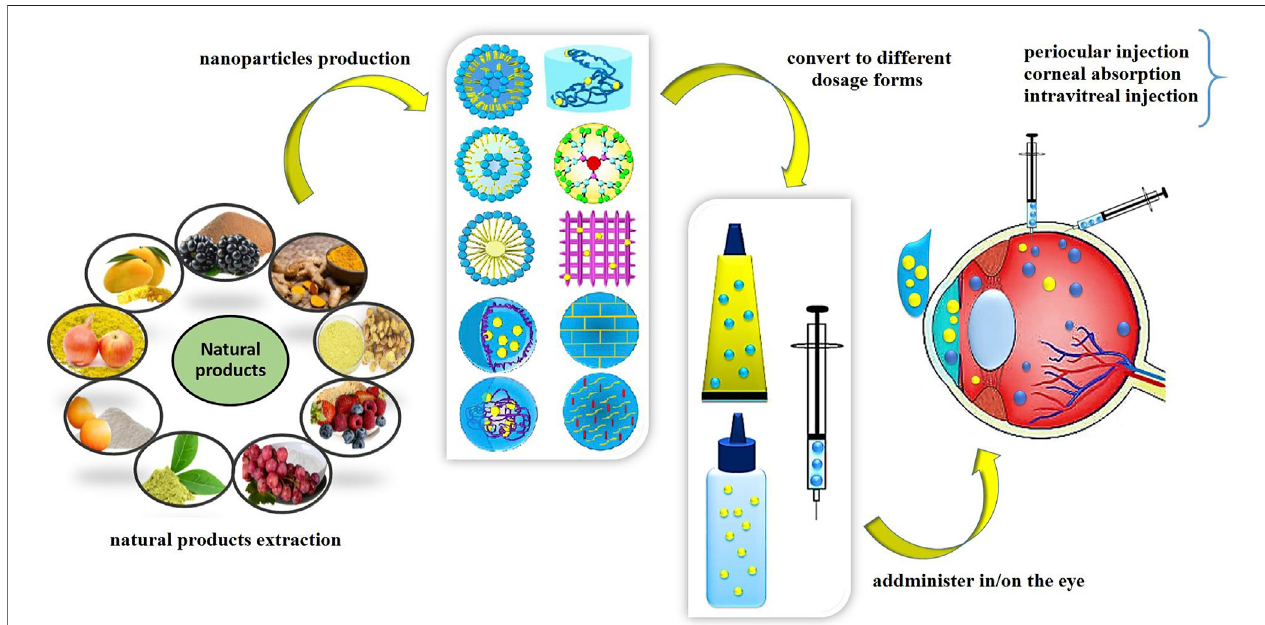
GRAPHICAL ABSTRACT | Application of nanostructures in ocular delivery of natural products.